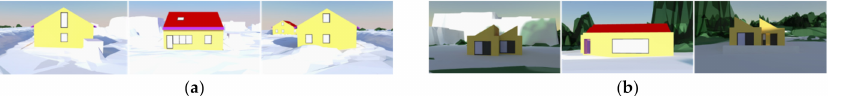
Figure 7. Shading of east, south and west facades on the 15. February with solar position 135 ◦ (SE), 180 ◦ (S) and 225 ◦ (SW). ( a ) TWIN, Holzkirchen, DE; ( b ) ZEBLL, Trondheim,